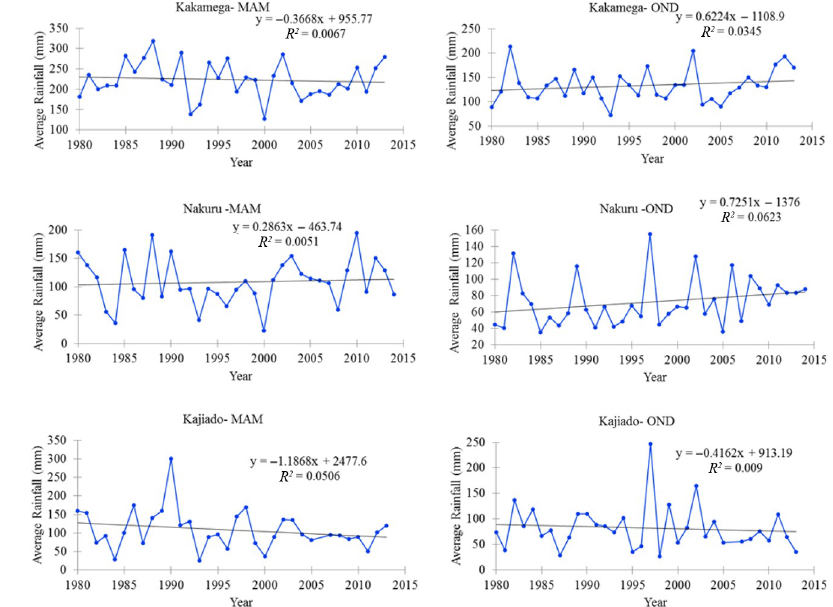
Figure 3. Mann–Kendall graphs showing average annual seasonal rainfall